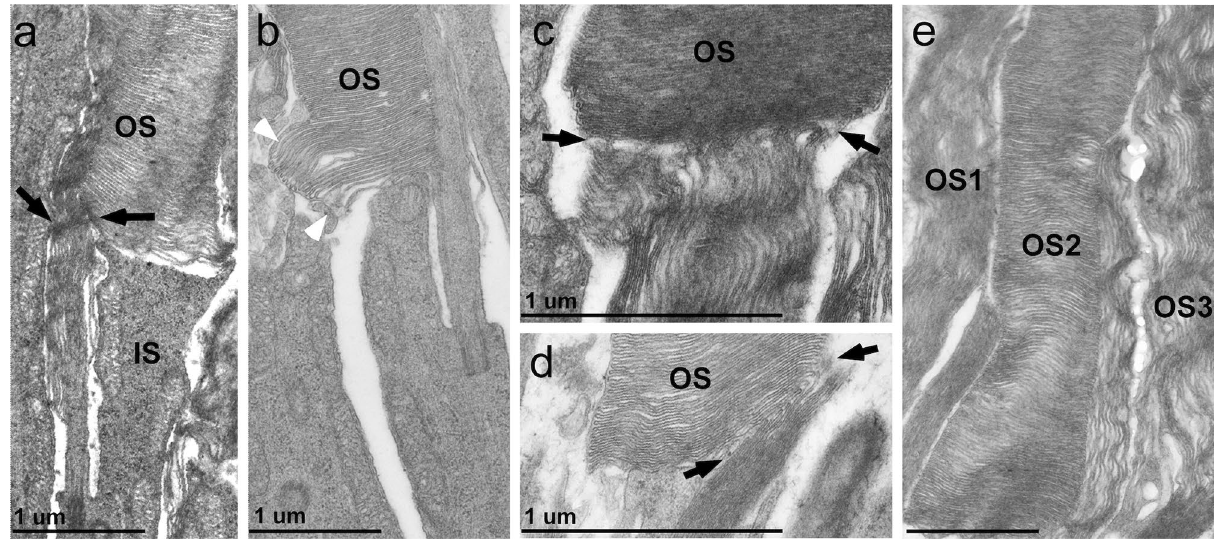
Figure 6. High-resolution TEM analysis of Fam161a tm1b/tm1b retina. a single photoreceptor cell from 1-month- old Fam161a tm1b/tm1b mouse representing different processes. ( a ) New discs with different orientation are marked in black arrows. Scale bar: 1 um. ( b ) Overgrow of disks is marked by white arrowheads. Scale bar: 1 um. ( c , d ) Zoom-in into the exact location where the orientation of the discs changes (marked in black arrows). ( e ) Different morphology in the same retina at the age of 1 month is observed. Three different outer segments are shown (OS1, OS2, OS3), and one of them (OS2) shows correct